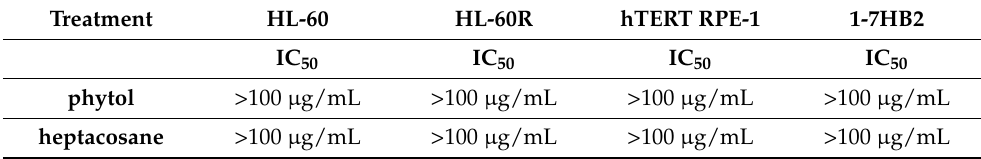
Table 1. IC 50 values of the three cell lines treated with phytol and heptacosane. Treatment